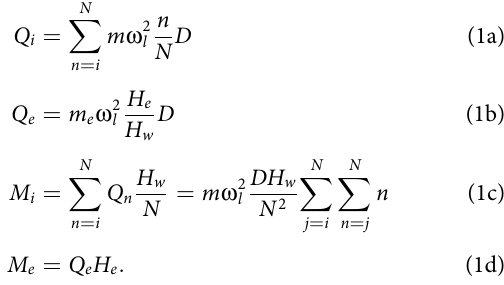
Frontiers in Built Environment |